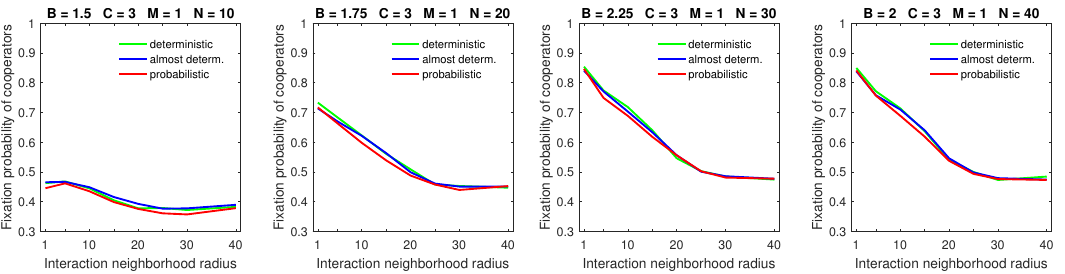
Figure 9. Deterministic dispersal results in slightly higher fixation probabilities of cooperators for a low mobility rate and a medium dispersal range. In all graphs, R = 3.